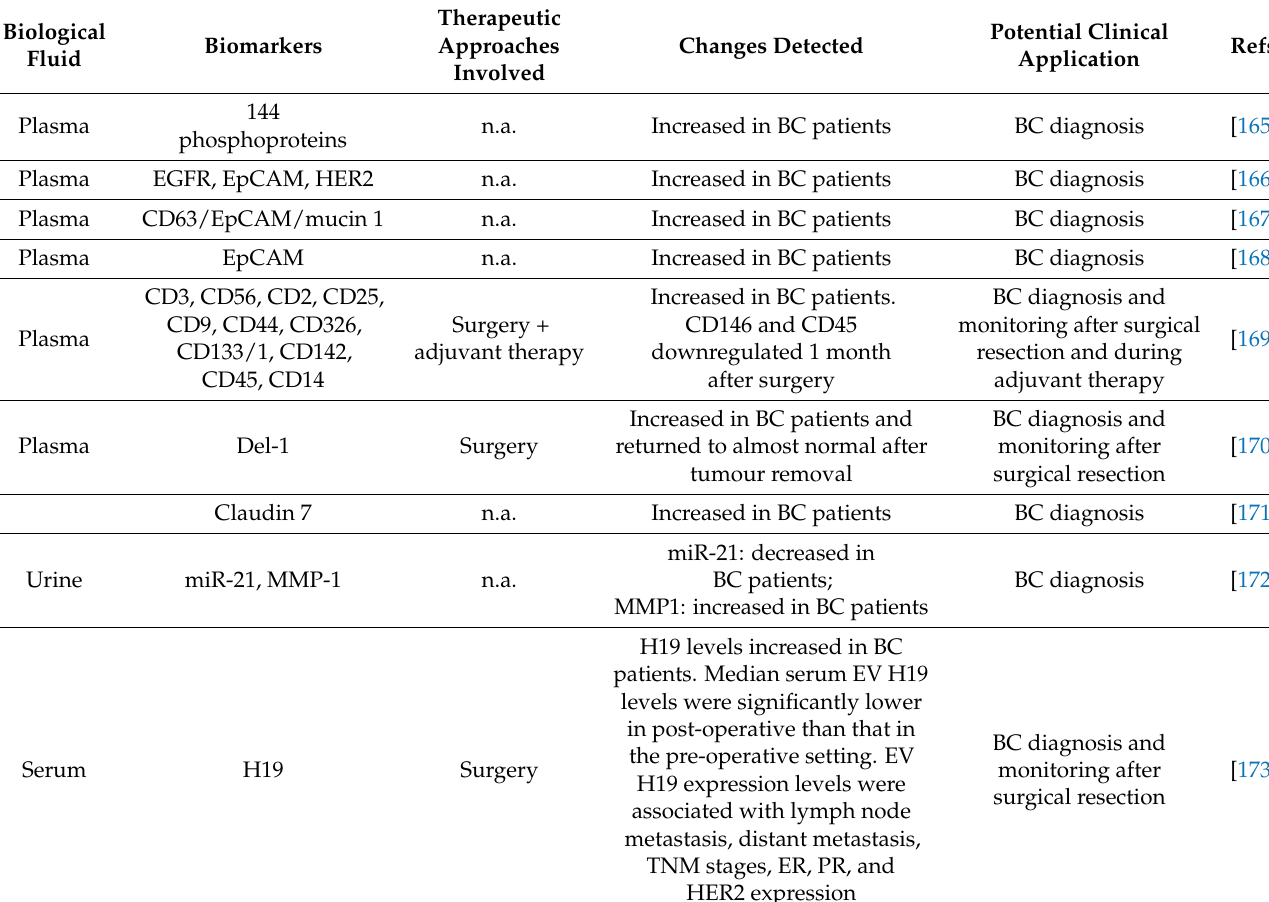
Table 2. Circulating EVs as diagnostic and prognostic